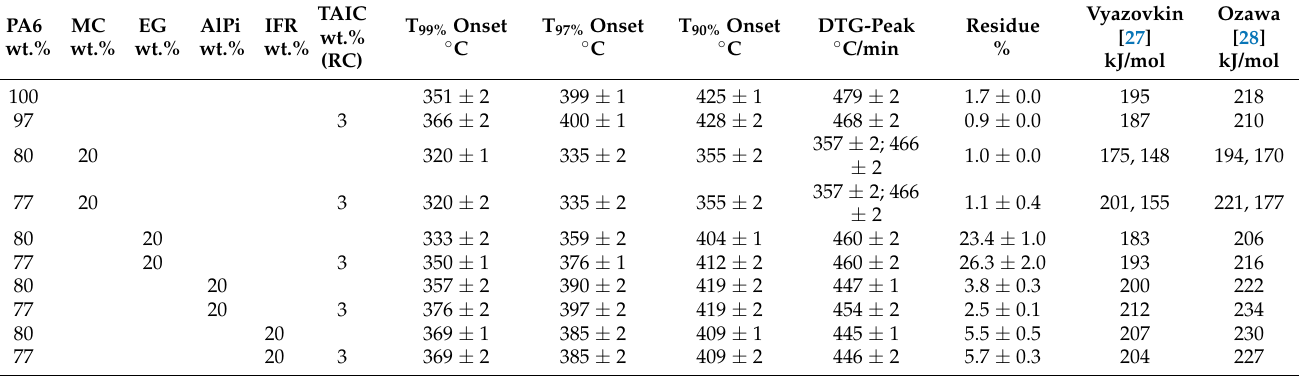
Figure 7. Activation energy evaluated for net PA6 and PA6 containing 20 wt.% MC, EG, AlPi, and IFR were calculated using the model introduced by Ozawa. TGA measurements were conducted at 2.5, 5 and 10 K/min under nitrogen atmosphere. Table 2. TGA